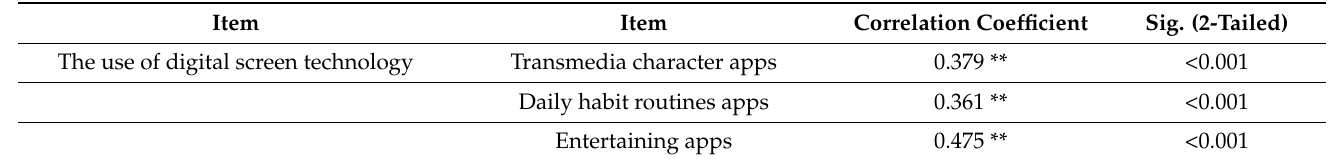
Table 4. Spearman’s correlations of the use of digital screen technology with applications offered by parents; significant correlations are